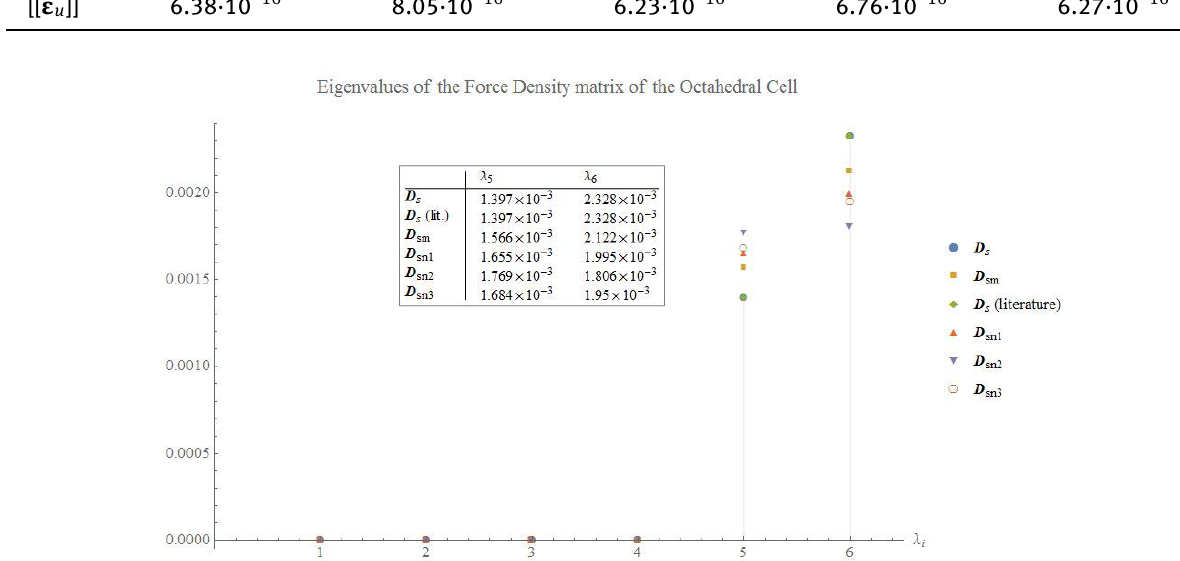
Figure 12: Eigenvalues of the Force Density matrices of the tensegrity Octahedral